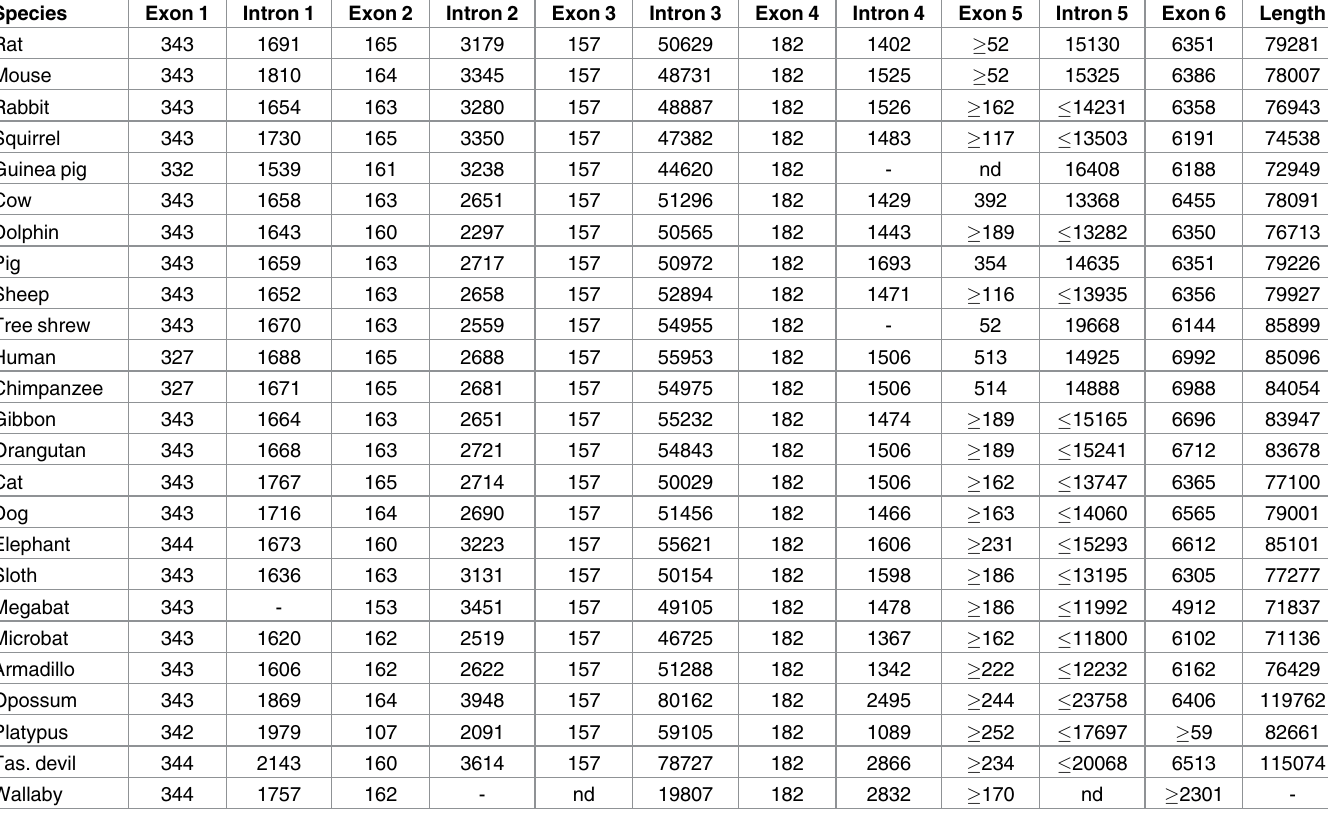
Table 1. Organization of mammalian IGF1 genes *